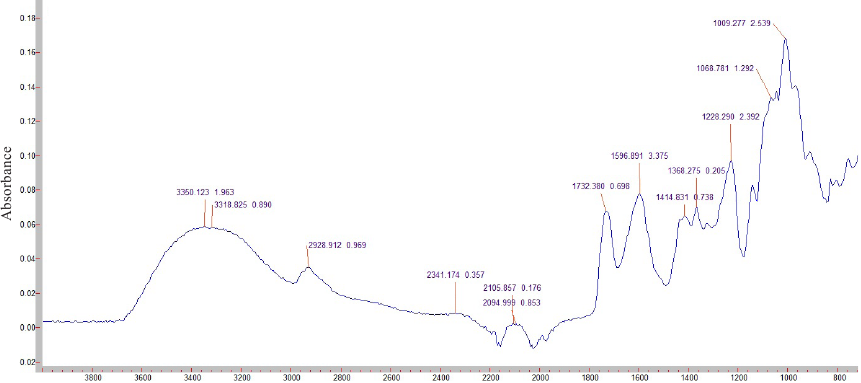
Figure 4 IR spectrum of pectin obtained by extracting with succinic acid